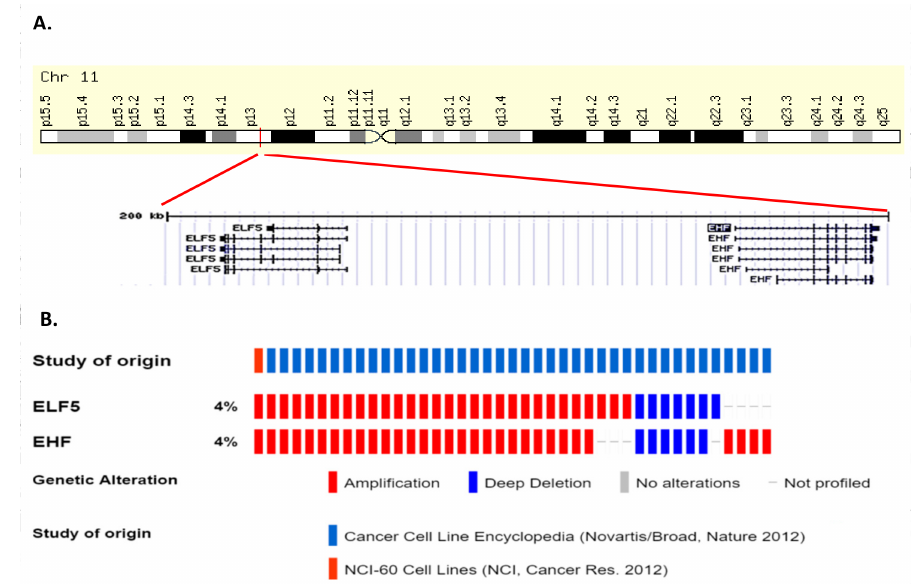
Figure 6. ( A ) Chromosomal location of ELF5 and EHF at location 11p13. ( B ) Amplification and deletion pattern of ELF5 and EHF across a panel of cancer cell